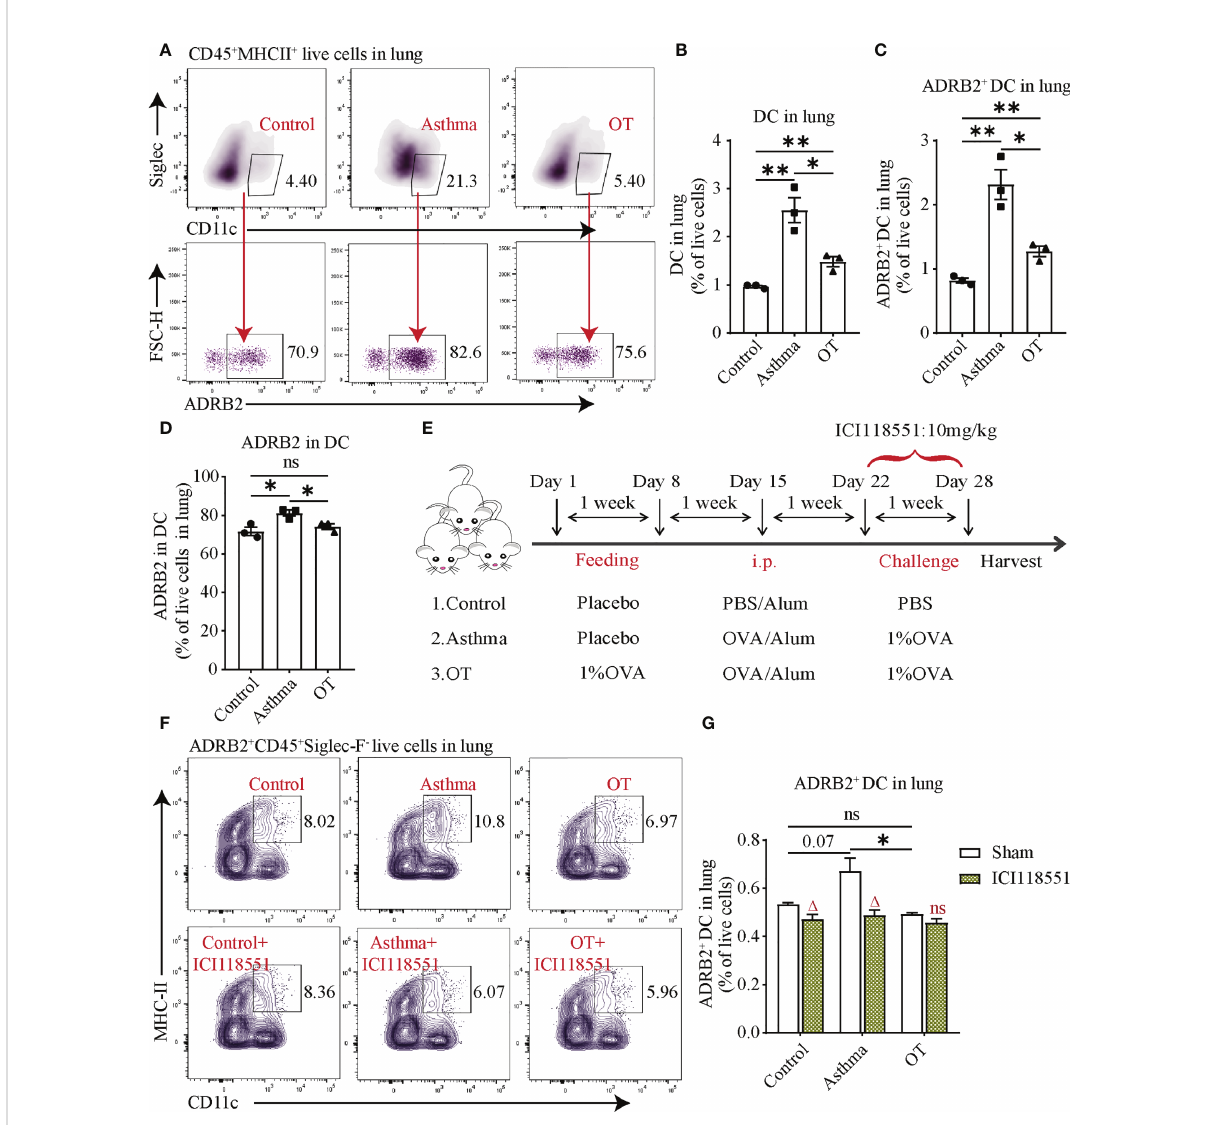
FIGURE 6 ADRB2 + DCs in asthmatic lungs are downregulated after treatment with ICI118551. (A) Flow cytometry gating strategy for ADRB2 + CD45 + Sigelc-F- CD11c + MHCII + DCs in lung tissue. Flow cytometry analysis for (B) DCs, (C) ADRB2 + DCs, and (D) ADRB2 in DCs in lung tissue from the control, asthmatic, and OT lungs. (E) Experimental protocol for establishing asthma and OT mouse models with or without ICI118551 treatment. (F, G) Flow cytometry analysis for ADRB2 + DCs in lung tissue after treatment with ICI118551. Results are from one representative experiment of at least two independent experiments. All bars in this fi gure indicate mean ± SEM. * P < 0.05, **P < 0.01 (unpaired two-tailed Student ’ s t-test). (A – D) , N = 3); ns, not signi fi cant. * P < 0.05 represent multiple comparisons of control, asthma and OT groups (corrected by one-way ANOVA with Tukey ’ s test) and △ P < 0.05 represent comparisons of adjacent bars of ICI118551 and sham in each group (unpaired two-tailed Student ’ s t-test) (E – G) , N = 3-4); ns, not signi fi